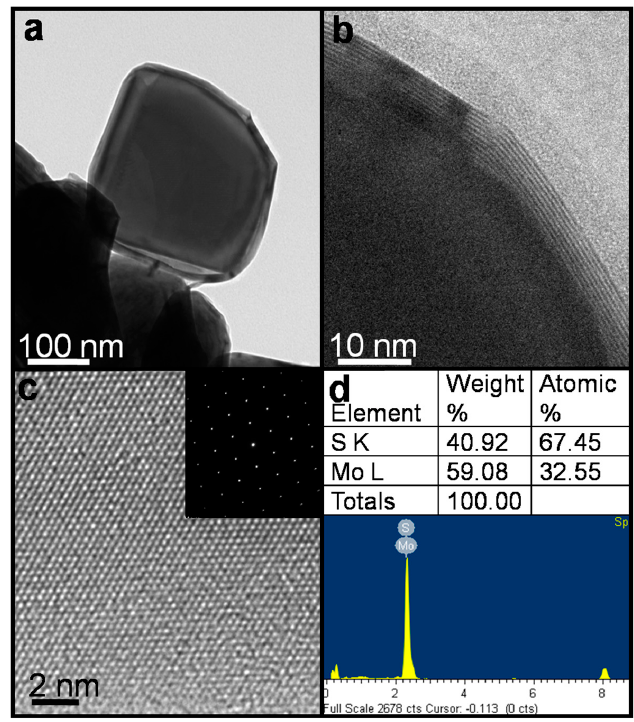
Figure 2. TEM analysis of IF-MoS 2 NP: ( a ) low-resolution image; ( b ) high-resolution image; ( c ) high-resolution TEM image of MoS 2 lamellar structure with clear lattice images. The inset shows diffraction pattern at a selected area. ( d ) Energy dispersive spectrometry (EDS) analysis of MoS 2 lamellar structure.